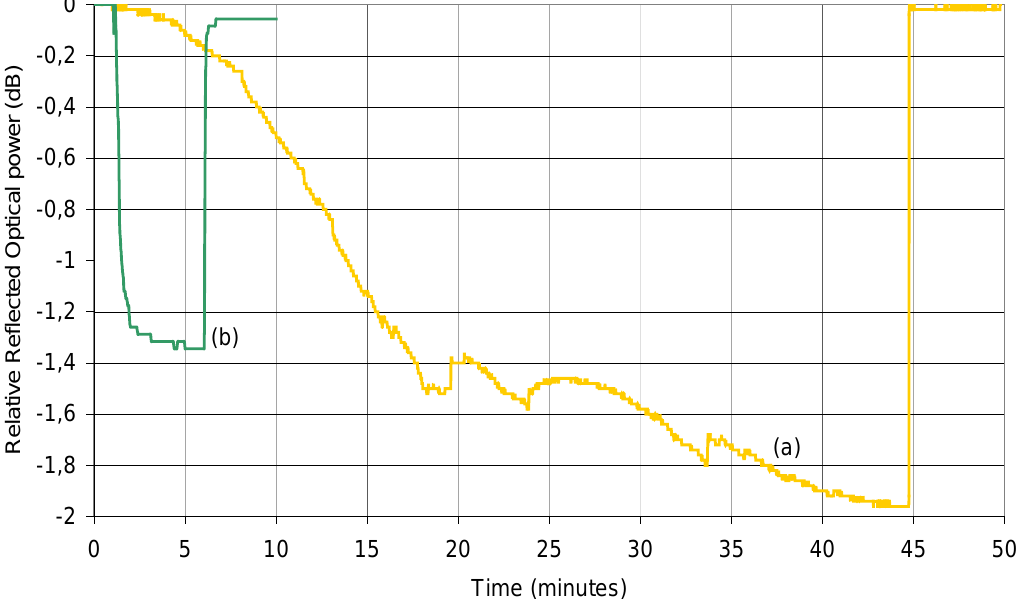
Figure 21 . Response of two ethanol sensors. Sensor (a) shows a higher dynamic range, sensor (b) has lower dynamic range, but their response time is less than one